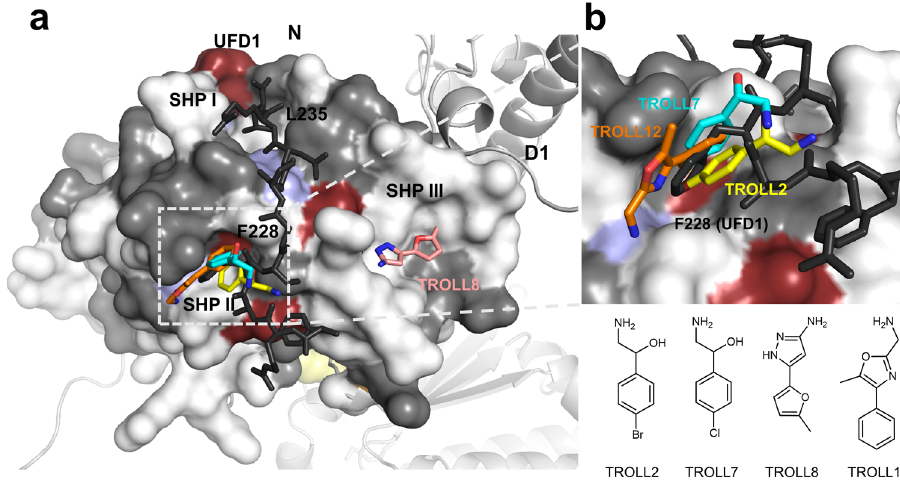
Fig. 7 Overlap between postulated and experimentally veri fi ed fragment binding sites on p97 with the interaction sites of UFD1. a Binding sites of TROLL7, TROLL8 and TROLL12 identi fi ed in the mixed-solvent MD simulations, as well as the crystal structure of TROLL2 superimposed with the bound UFD1-SHP-peptide (PDB entry 5B6C) mapped onto a surface representation of the N-domain. Additionally, the highest chemical shifts of the 1 H- 15 N- HSQC-NMR measurements are shown, colored in terms of standard deviation as in Fig. 6. b Zoom into the SHP II binding site, which is occupied by F228 in the structure of the p97-N-UFD1 peptide complex and is addressed by TROLL2, TROLL7 and TROLL12. Based on the 1 H- 15 N-HSQC-NMR measurements, and, in contrast to the fi ndings from the mixed-solvent MD simulations, TROLL8 seems to bind to a sub-pocket (SHP I) which is occupied by L235 in the structure of the p97-N-UFD1 peptide